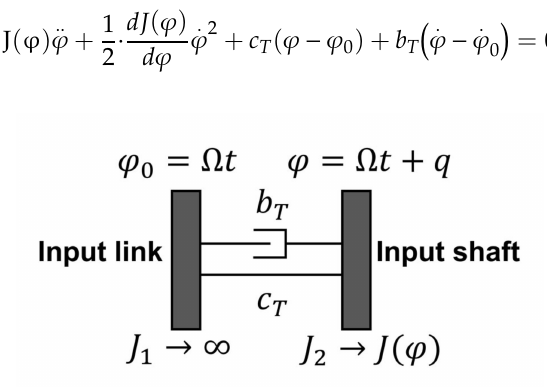
Figure 3. Model of self-excited torsional vibration